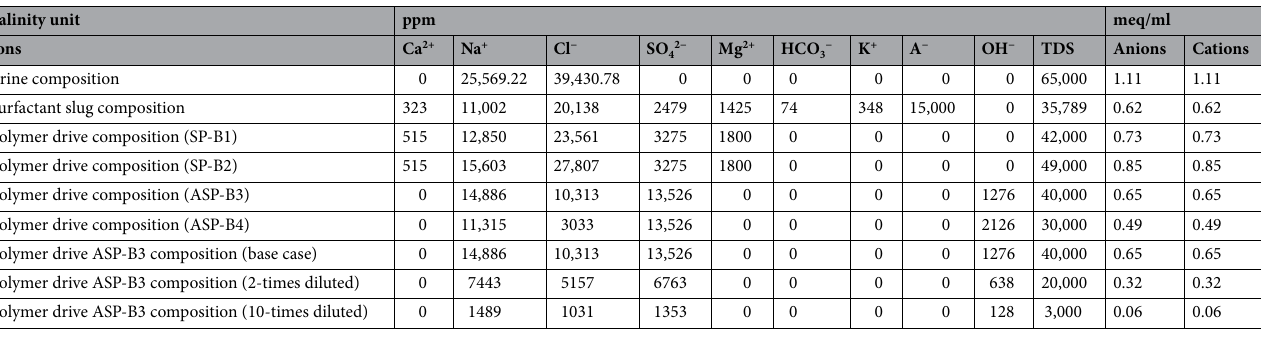
Table 11. Compositions of different fluid compositions used in the simulation runs for the sensitivity analysis study.